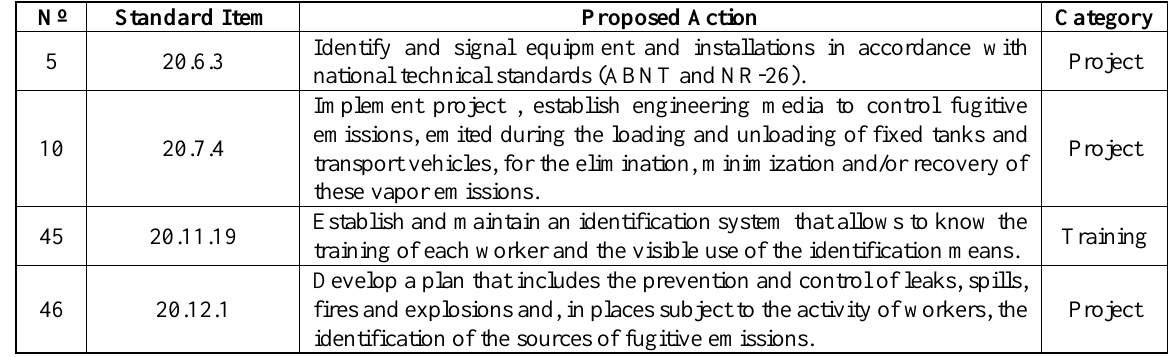
Table 2: Action plan for correction of Non-Conformities